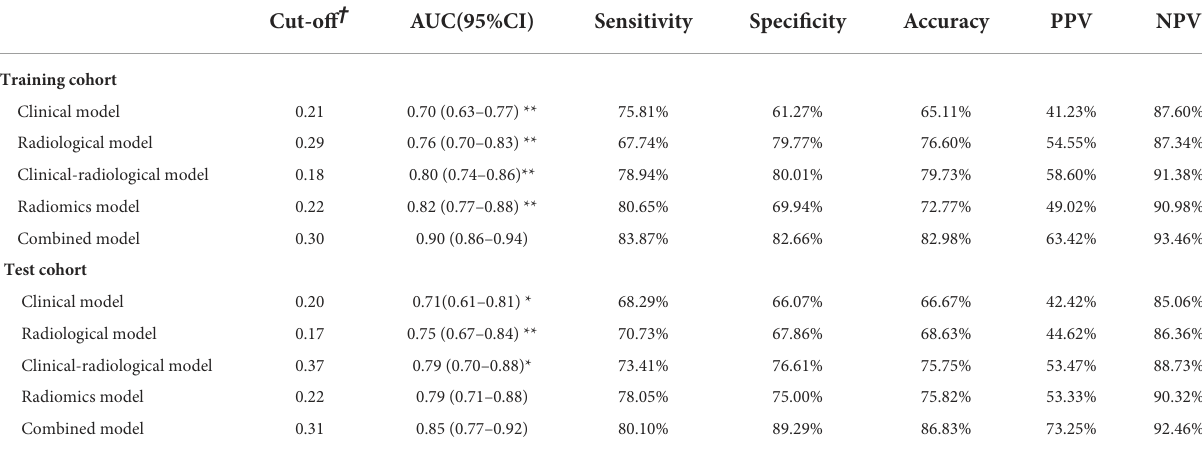
TABLE 5 Performance comparison of five models in the training and test cohorts. Cut-off † AUC(95%CI) Sensitivity Specificity Accuracy PPV